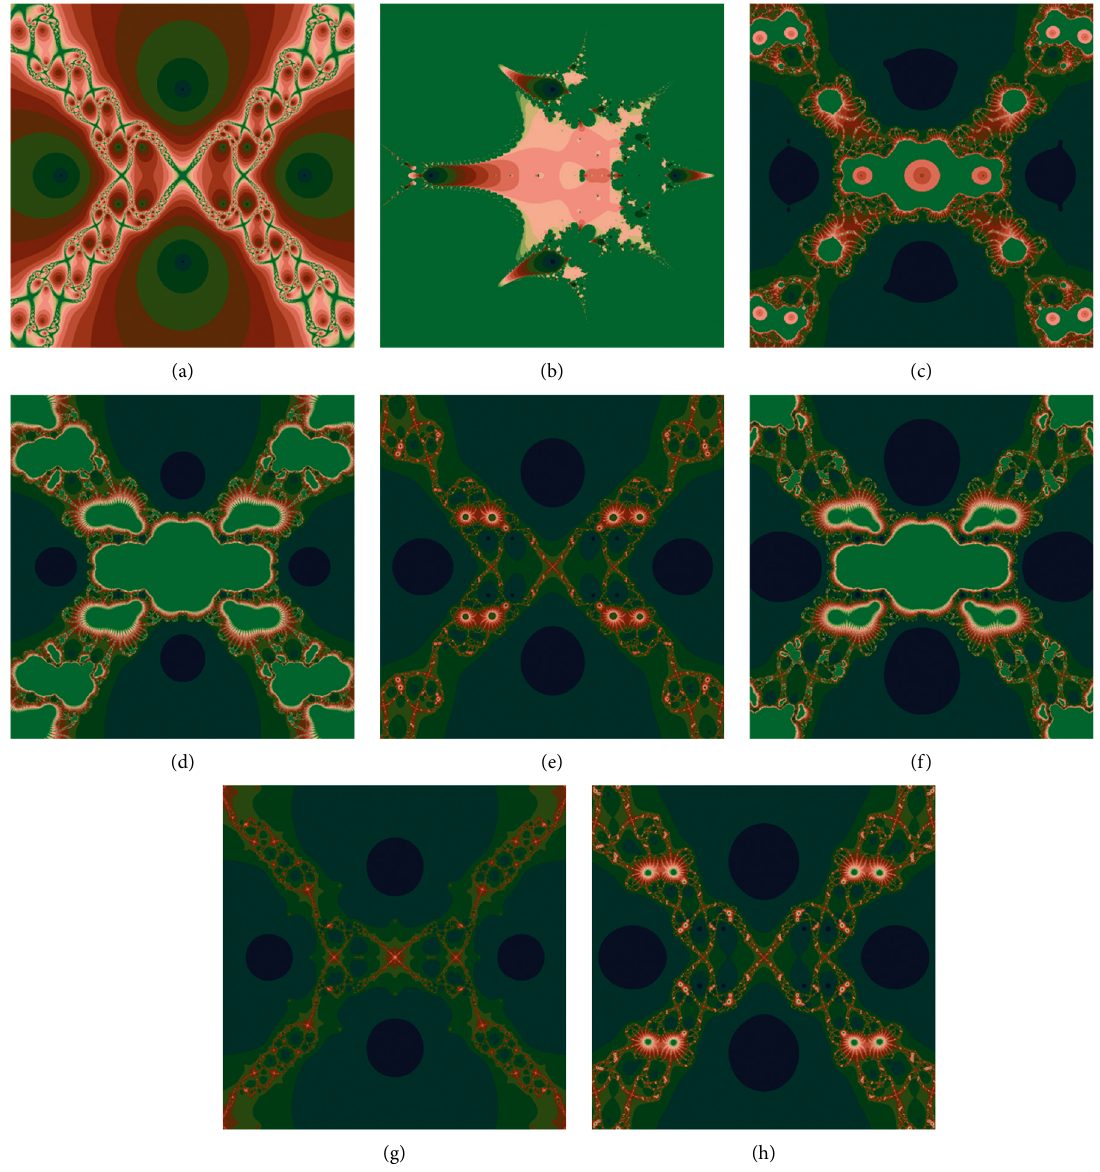
Figure 7: Polynomiograph for q